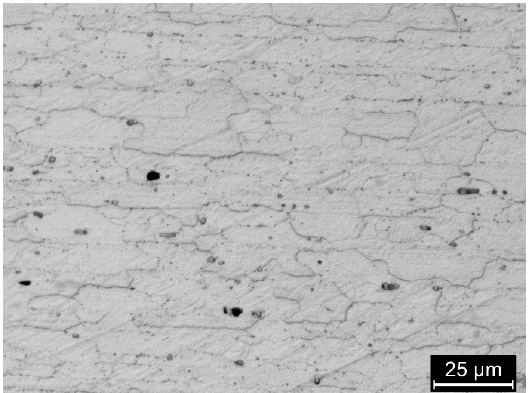
Figure 6. Optical image (Keller attack) of the HAZ of the FWS AA 7075 alloy. The grains appear elongated along the rolling direction; presence of macro ‐ precipitates is evident.